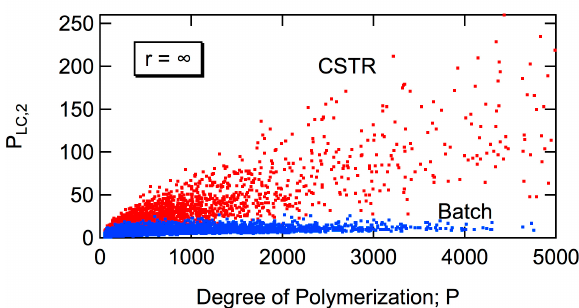
Figure 9. Relationship between the number P LC,2 of units belonging to the largest cluster of the second order and the degree of polymerization P , for a batch and a CSTR with r = ∞ . ξ = 0.25 for CSTR, and x A = 0.95 for batch.